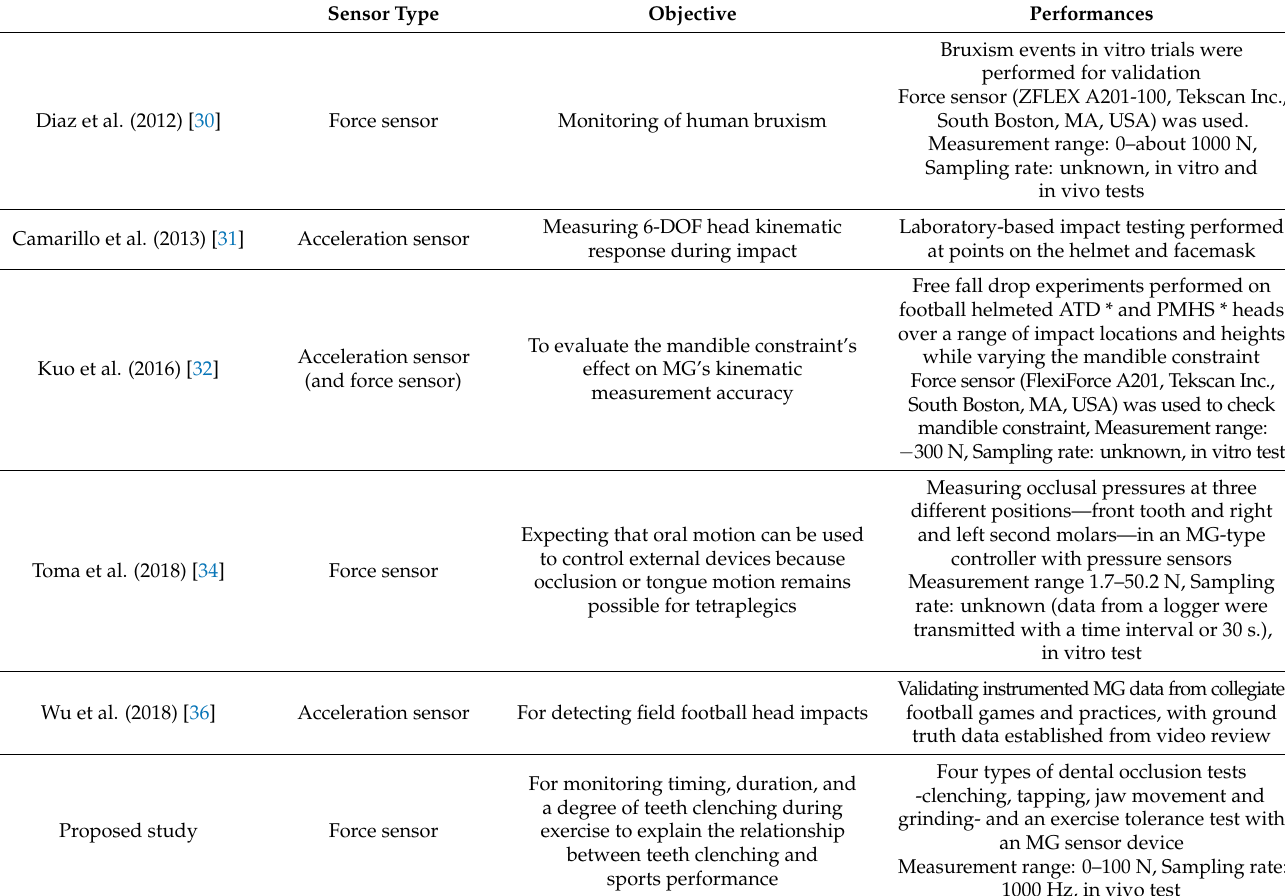
Table 1. Prior study focusing on mouth guard type sensors to measure physical quantities (force and acceleration). It is difficult to compare the force-measurement ranges considered in these studies because there are different measurement methods, e.g., force was applied to force sensor and mouth guard (MG)-type sensor.